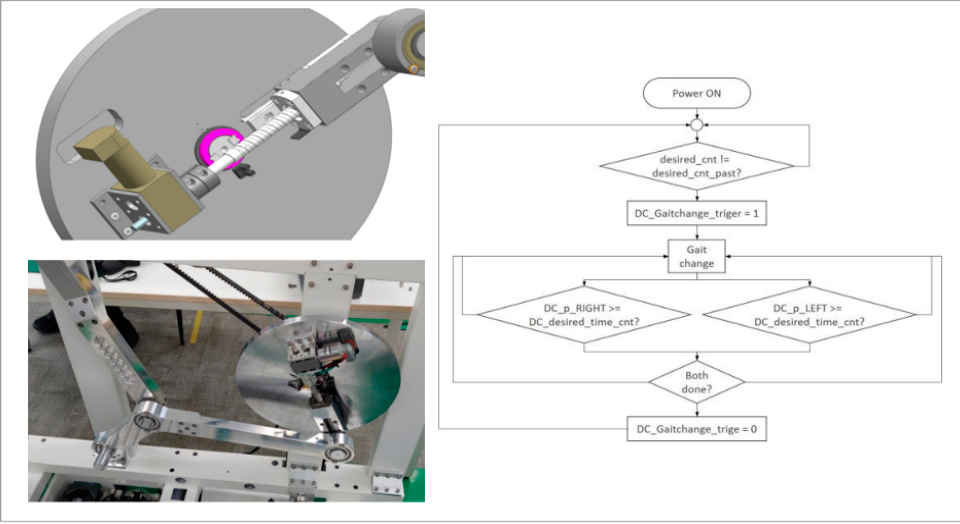
Figure 4. Step length control system algorithm.